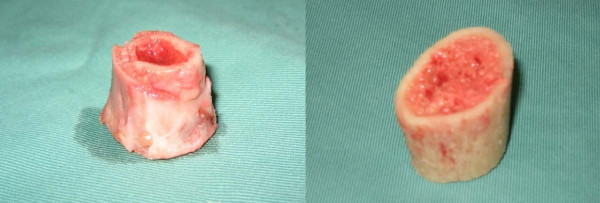
Specimen for analysis. The right is for biomechanical testing and left for histopathological examination.